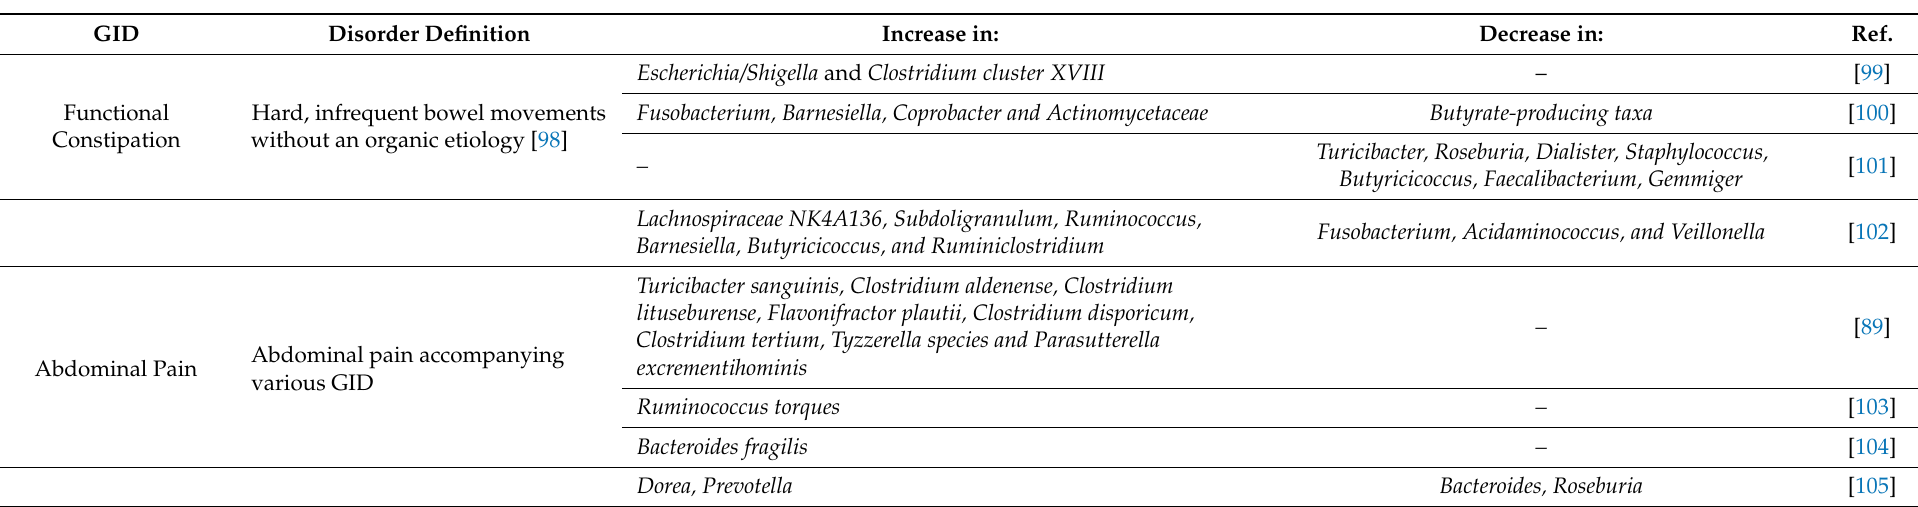
Table 1. Variations in bacterial species with functional gastrointestinal disorders in children with autism spectrum